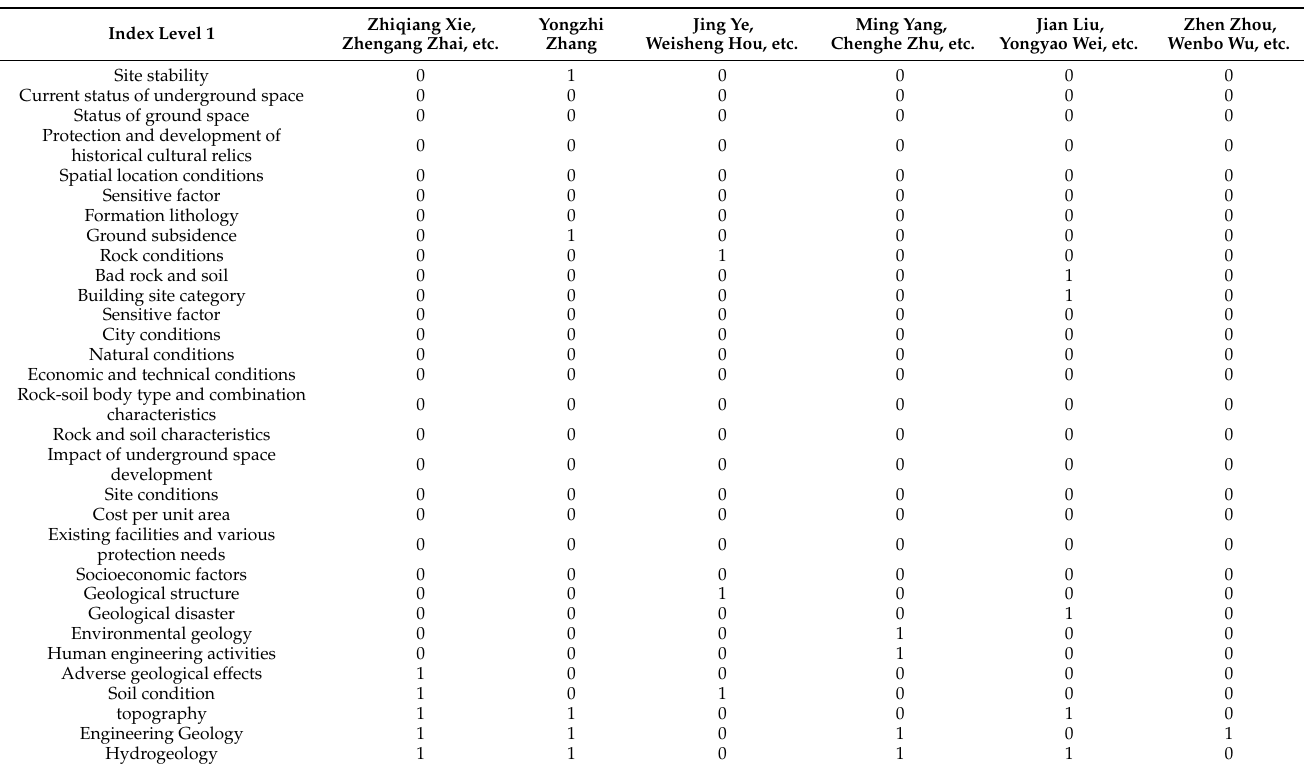
Table A2. First level index binarization matrix.